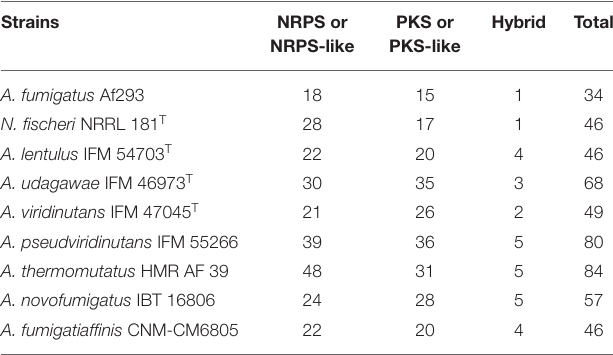
TABLE 2 | The numbers of SM backbone genes predicted in the genome of strains of Aspergillus section Fumigati . Strains NRPS or